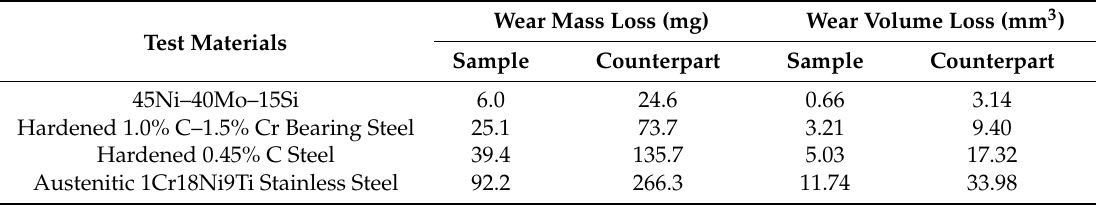
Table 1. Wear test results of different materials under block-on-wheel dry-sliding wear conditions with 147 N applied load at room temperature.